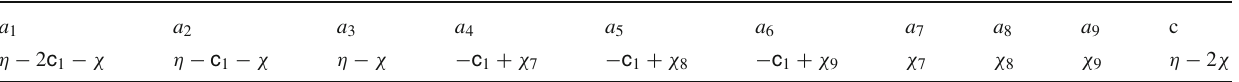
Table 1 Homology classes of the coefficients a j and c . Note that χ = χ 5 + χ 7 + χ 9 where χ 7 ,χ 8 ,χ 9 are the unspecified homologies of the coefficients a 5 , a 7 and a 9 respectively